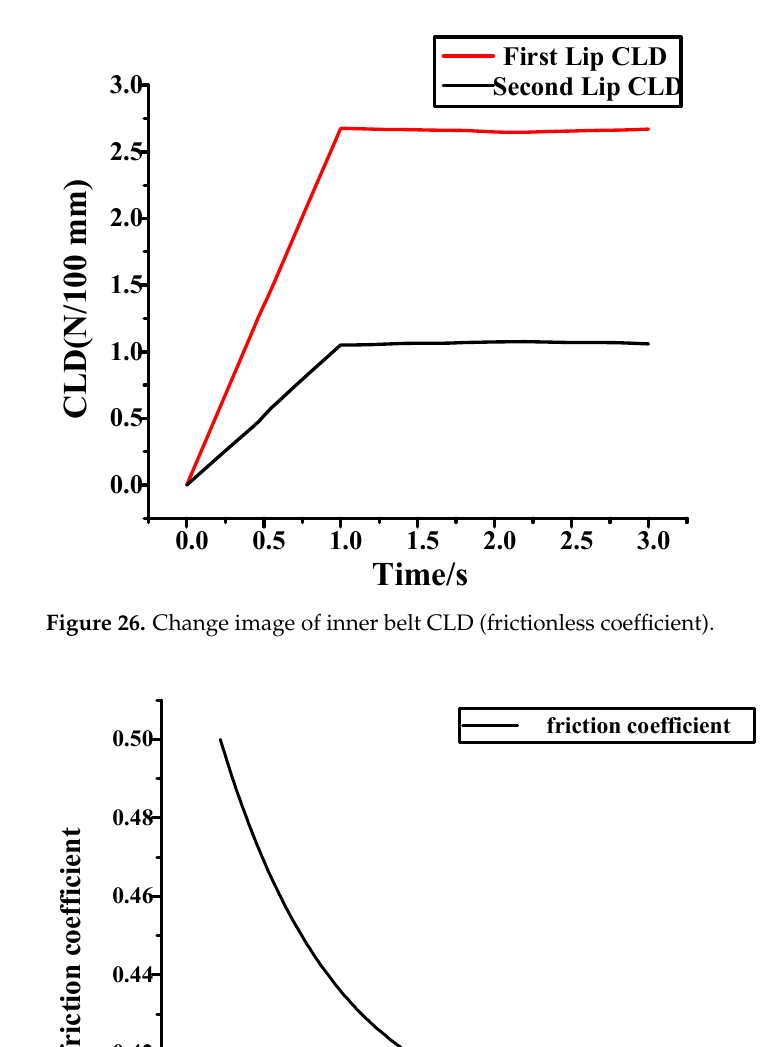
Figure 26. Change image of inner belt CLD (frictionless coefficient).